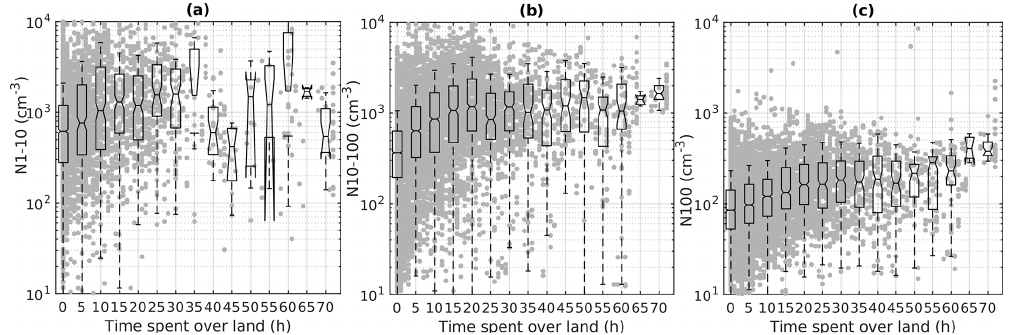
Figure 7. Number concentrations of particles in 1–10nm (a) , 10–100nm (b) , and above 100nm (c) as a function of time spent over land. The box plots show the statistics for the number concentrations binned for every 5h spent over land with the horizontal lines showing the medians, the notches showing the uncertainty in the median, the boxes showing the 25th–75th percentiles, and the whiskers indicating 1.5 times the 25th and 75th